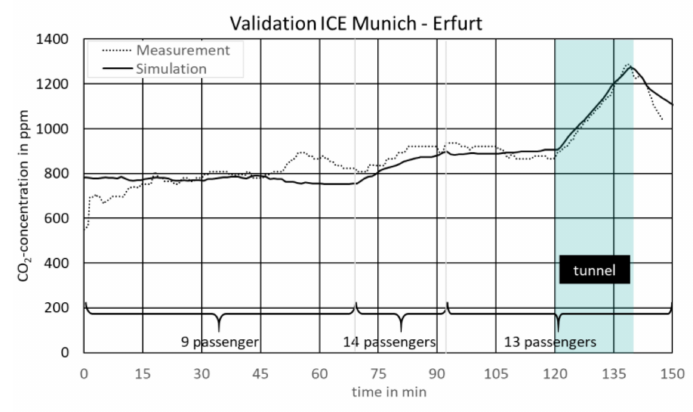
Figure 7. Comparison of measured and simulated CO 2 concentration on Munich–Erfurt route in an ICE